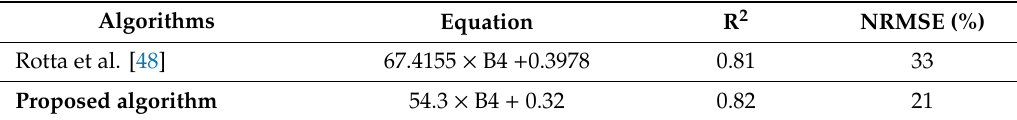
Table 6. Same as in Table 5 but for the di ff use attenuation coe ffi cient.